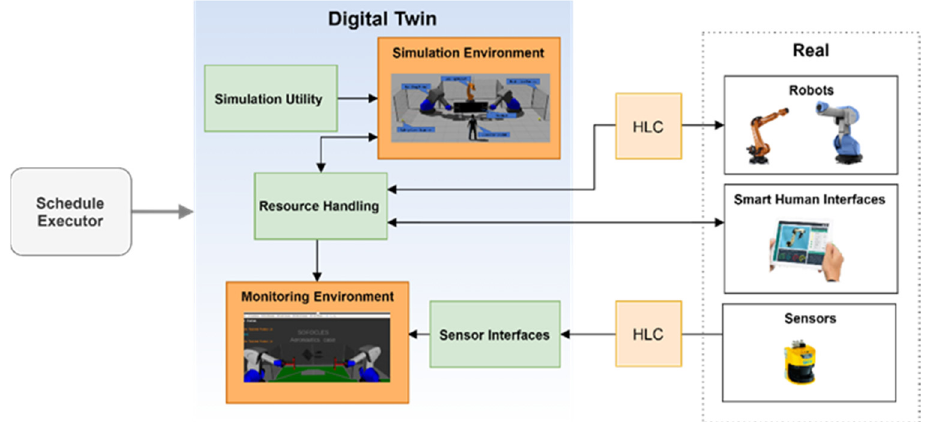
Figure 3. Digital twin architecture